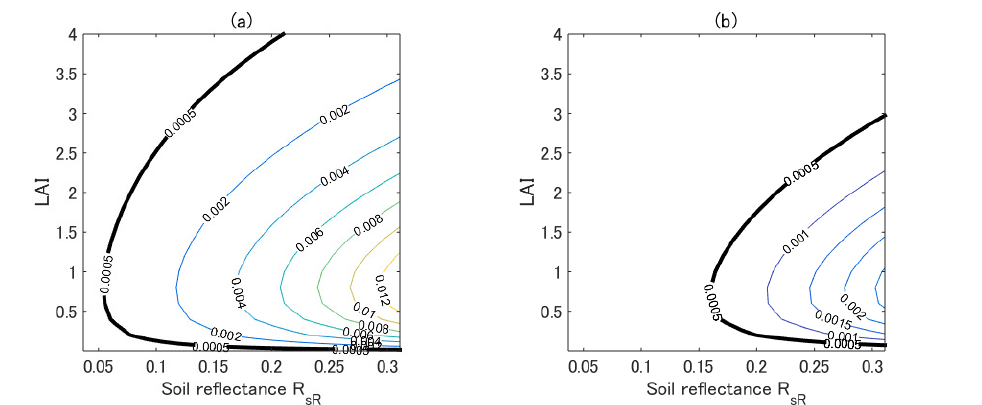
Figure 2. Comparison of the errors in the vegetation isolines with the error (0.0005) computed from the noise corresponding to a signal-to-noise ration (SNR) of 200 at the NIR reflectance of 0.1. ( a ) The error in the first-order isoline; and ( b ) the error in the asymmetric-order isoline. The thick solid lines indicate the contour lines corresponding to 0.0005.